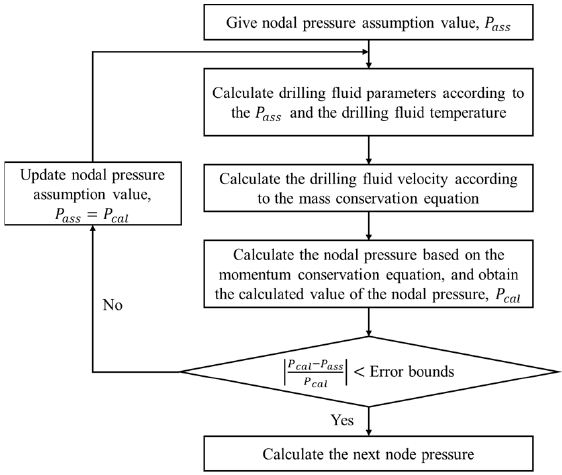
Figure 4. Wellbore pressure iterative solution process.